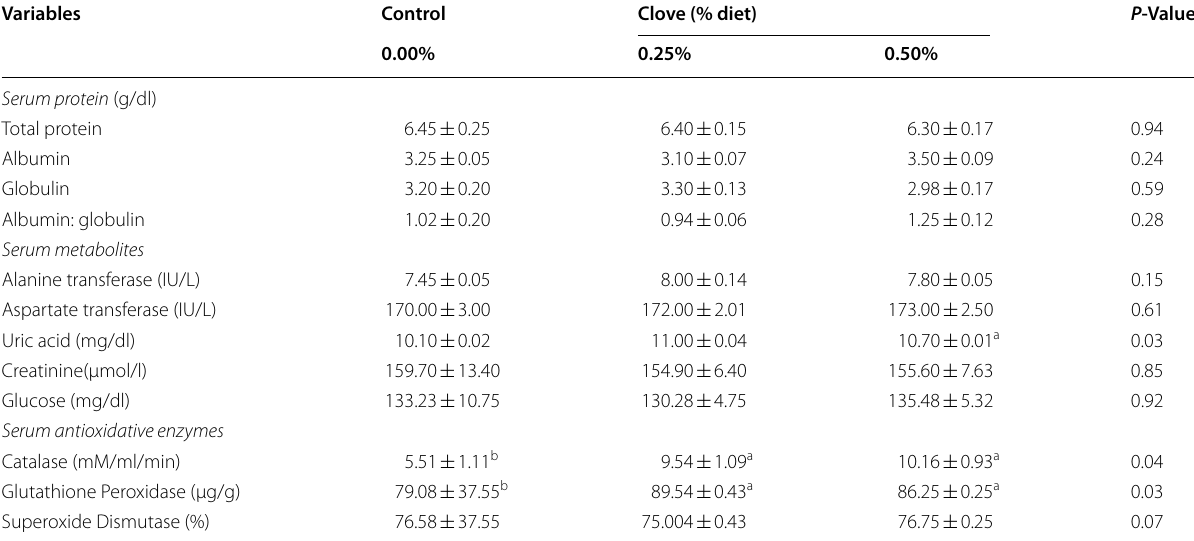
a, b are superscripts that indicates the means across the row were significantly different ( P <